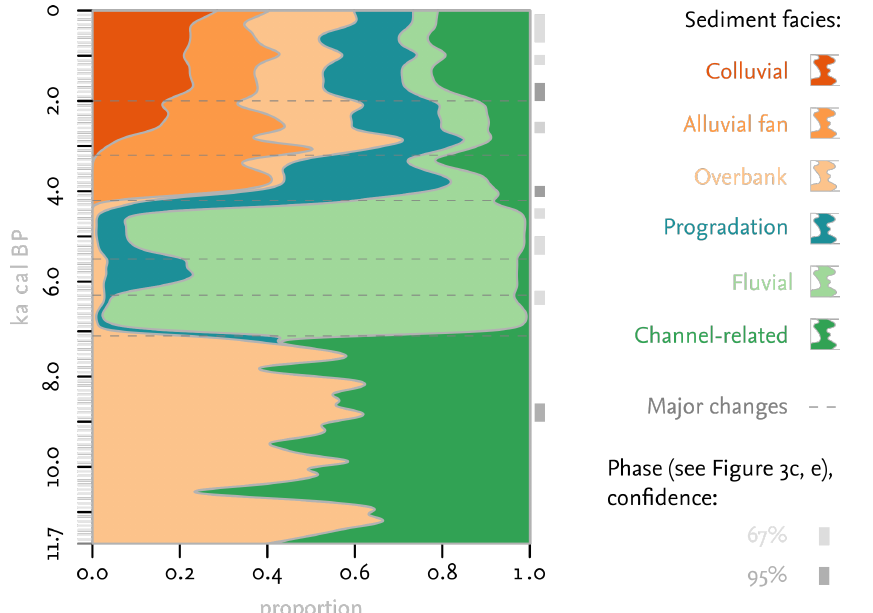
Figure 4. Modeled facies change (relative cumulative probability functions of estimated ages of sediment layers associated with different facies). Facies terminology is taken from the original publication and is thus not always